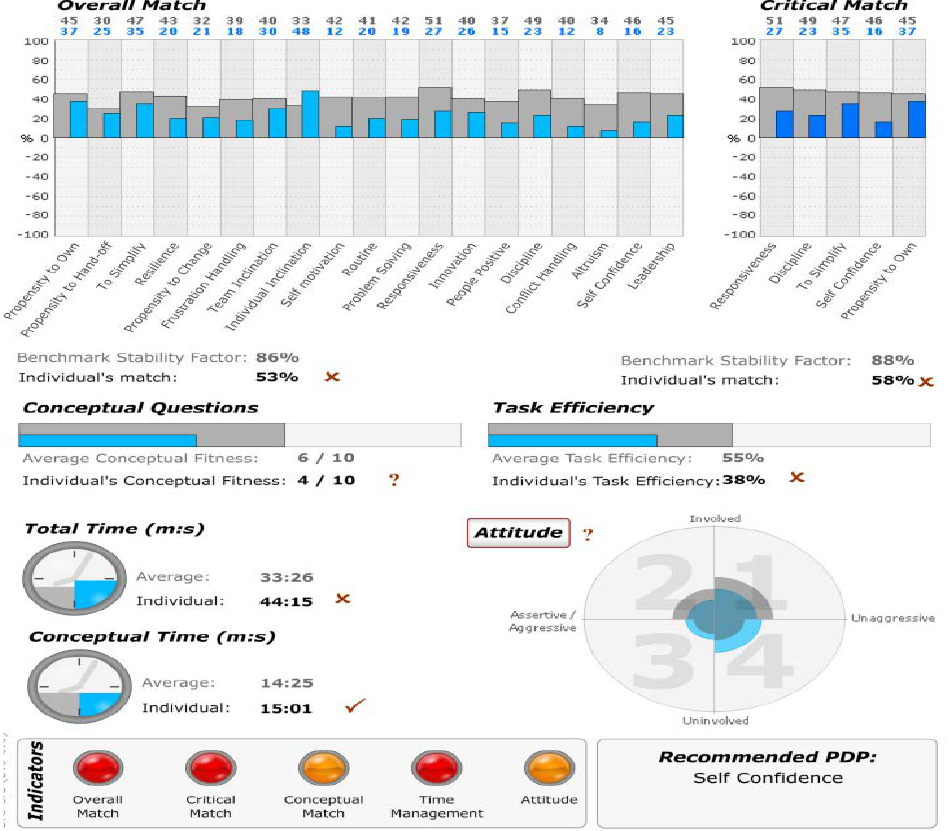
Figure 4. Demonstration: Individual match